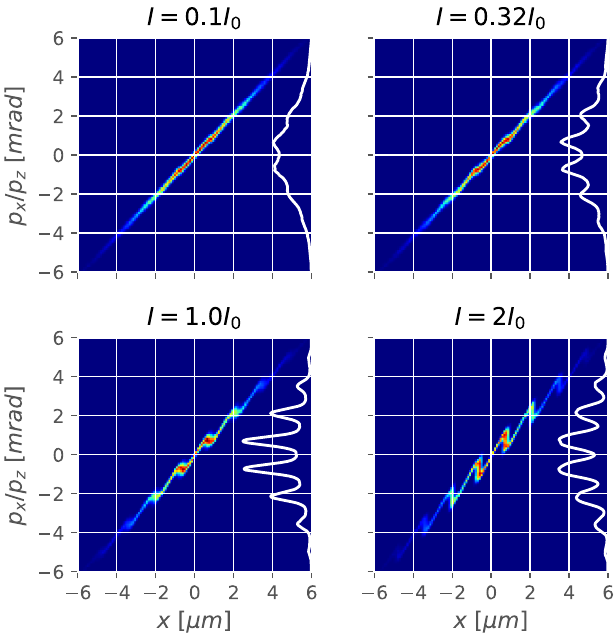
FIG. 3. Momentum space of electron beam ( γ e ¼ 100 , σ different laser intensities. As can be seen the modulation optimizes for a specific intensity and reduces again for higher values. White curve: transverse momentum space integrated along x (measured signal on